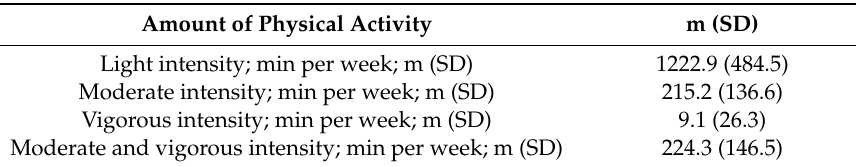
Table 2. Amount of physical